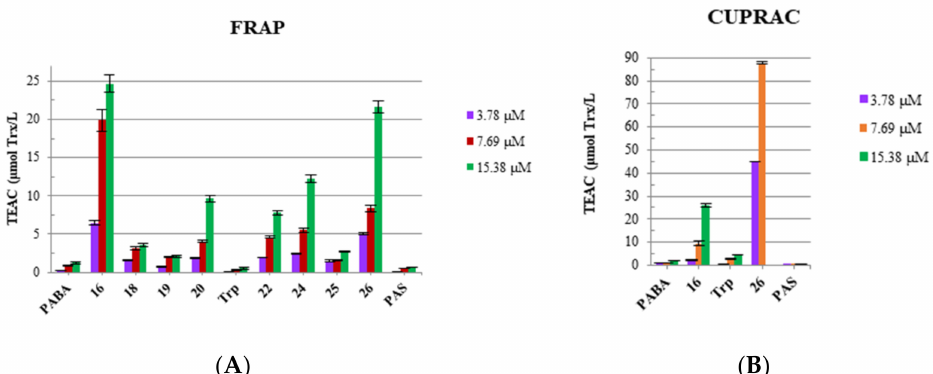
Figure 6. Antioxidant potential expressed as Trolox Equivalent Activity (TEAC) of (+)6 or (+)10-charged 16 , 18 , 20 , 22 , 24 , and 26 bola dendrimers and their neutral precursors 19 and 25 at three concentrations (3.78, 7.69, and 15.38 µ M) measured as Ferric Reducing Antioxidant Power (FRAP) ( A ) or Cupric Reducing Antioxidant Capacity (CUPRAC) ( B ) in relation to the known concentrations of Trolox. For comparison are given data for p -aminobenzoic acid (PABA), p -aminobenzenesulfonic acid (PAS), and tryptophane